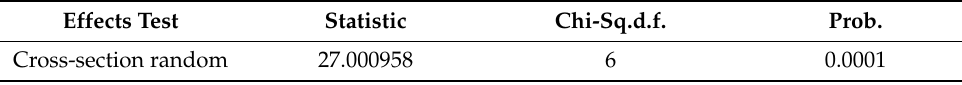
Table 4. The results of the Hausman test.